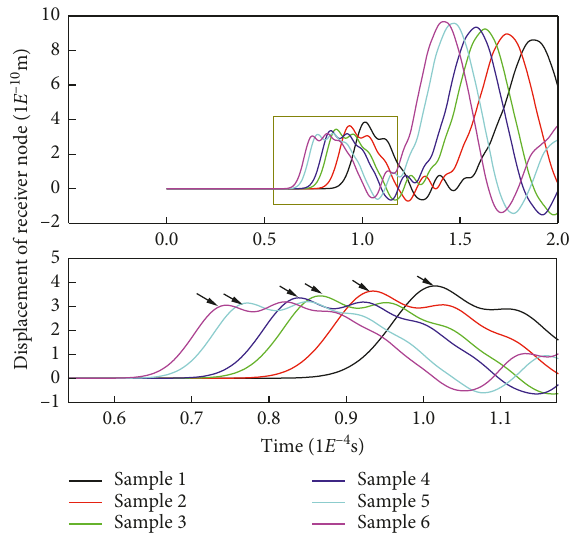
Figure 15: Displacement of receiver node.